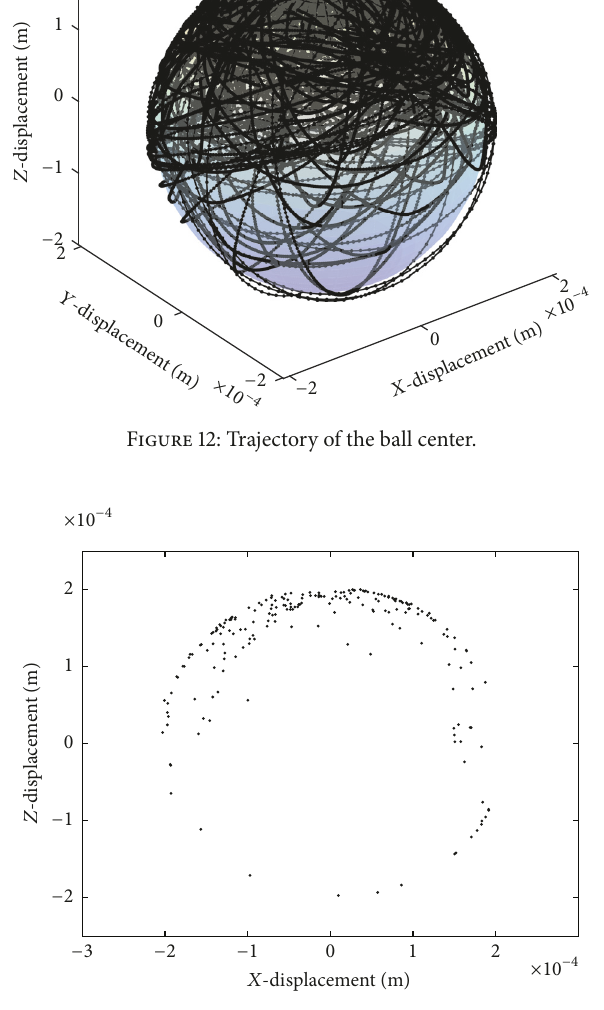
Figure 13: Poincare maps.